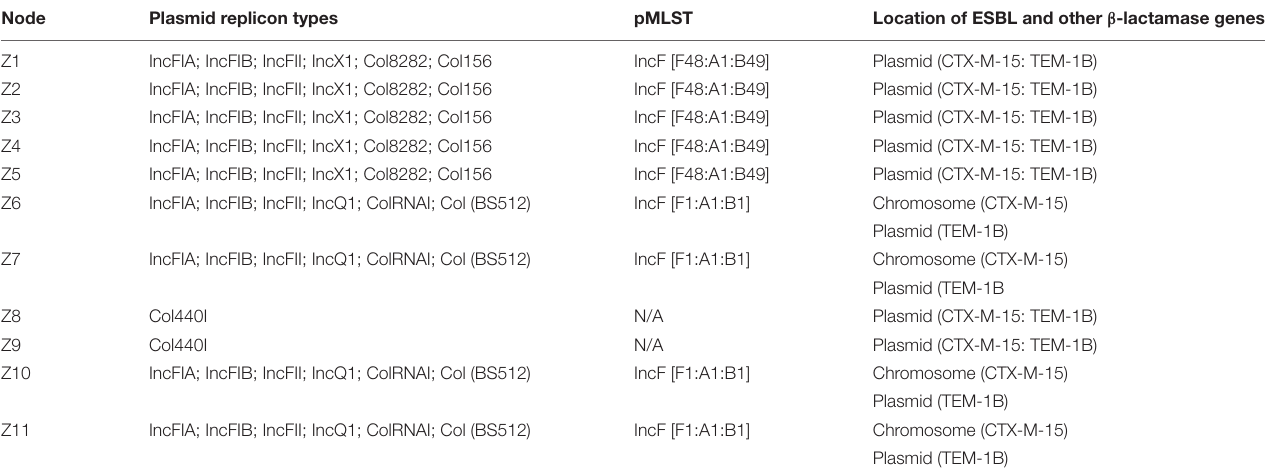
TABLE 4 | Plasmid profiles and location of the β -lactam genes in ESBL-producing Escherichia coli.